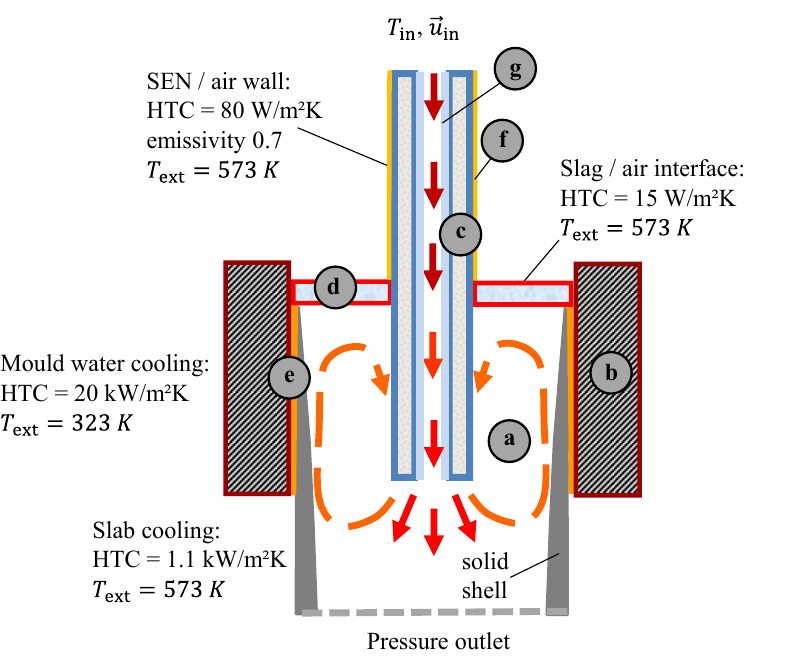
Figure 2. Schematics of the simulation domain: ( a ) melt pool, ( b ) water-cooled CC mold, ( c ) refractory SEN wall, ( d ) slag band, ( e ) 2 mm slag skin, ( f ) fiber insulation, and ( g ) SEN clogging layer.